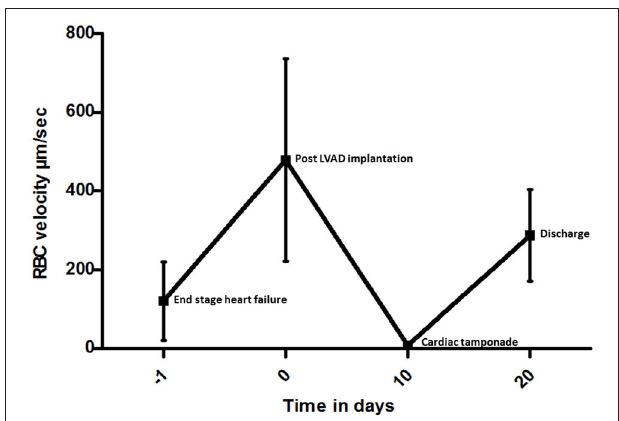
FIGURE 2 | Space-time diagram analysis of red blood cell (RBC) velocity measured in five representative capillary video sequences at each time point in individual vessels from the day before LVAD to discharge. The RBC values are shown with bars giving the standard